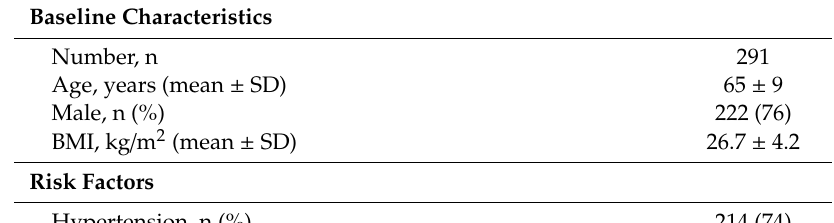
Table 1. Study population